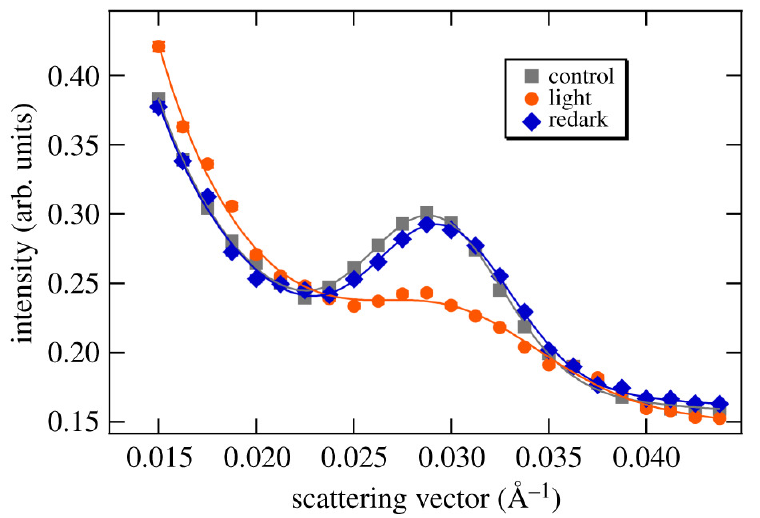
Figure 11. SANS data from a dark-adapted plant leaf showing the response of the thylakoid mem- branes to light cycling [266]. The image is Figure 1 of reference [266] by Ünnep et al., which was published under the Creative Commons Attribution License (https://creativecommons.org/licenses/ by/4.0/, accessed on 22 September 2022). The authors of reference [266] hold the copyright for the